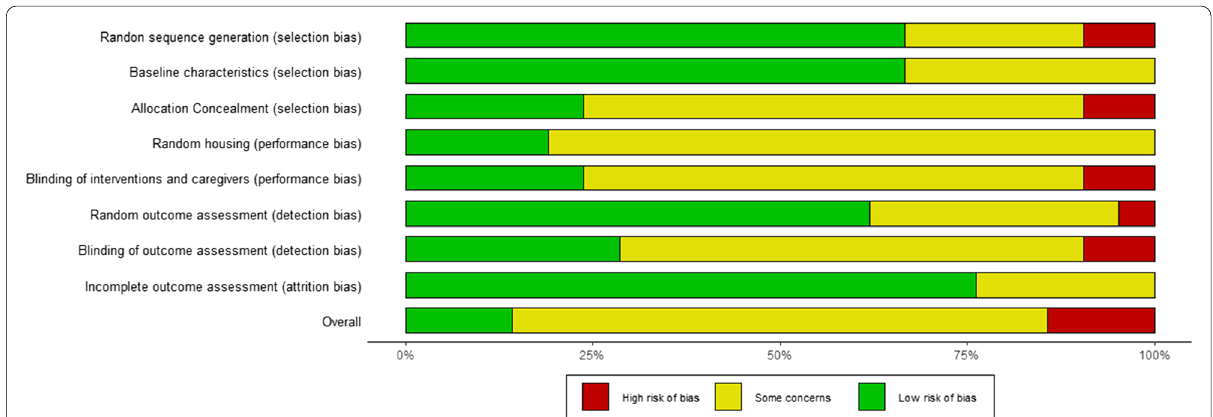
Fig. 4 SYRCLE’s risk of bias assessment for in vivo studies investigating the use of adipose tissue-derived products for the treatment of tendon